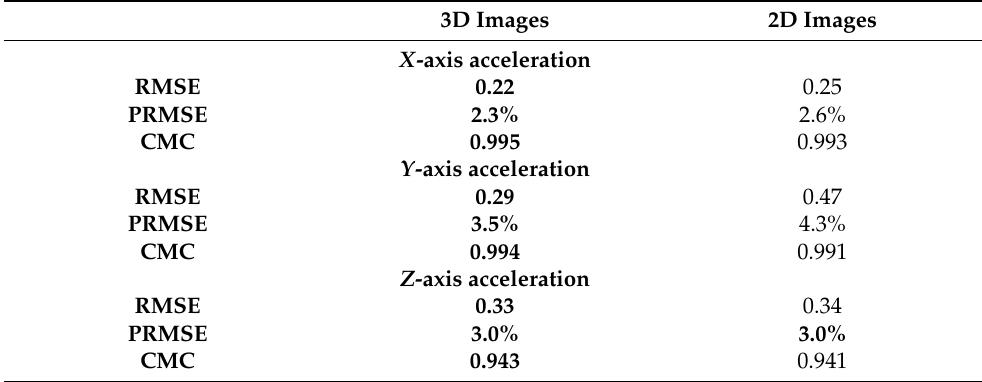
Figure 4. 2D/3D performance comparison; ( a – c ) represent the results of the x -, y -, and z -axis accelerations from known-view data, respectively; ( d – f ) represent the results of the x -, y -, and z -axis accelerations from unknown-view data, respectively. Table 3. Details for 2D/3D performance comparison in known-view testing. Note that the best performances are marked in